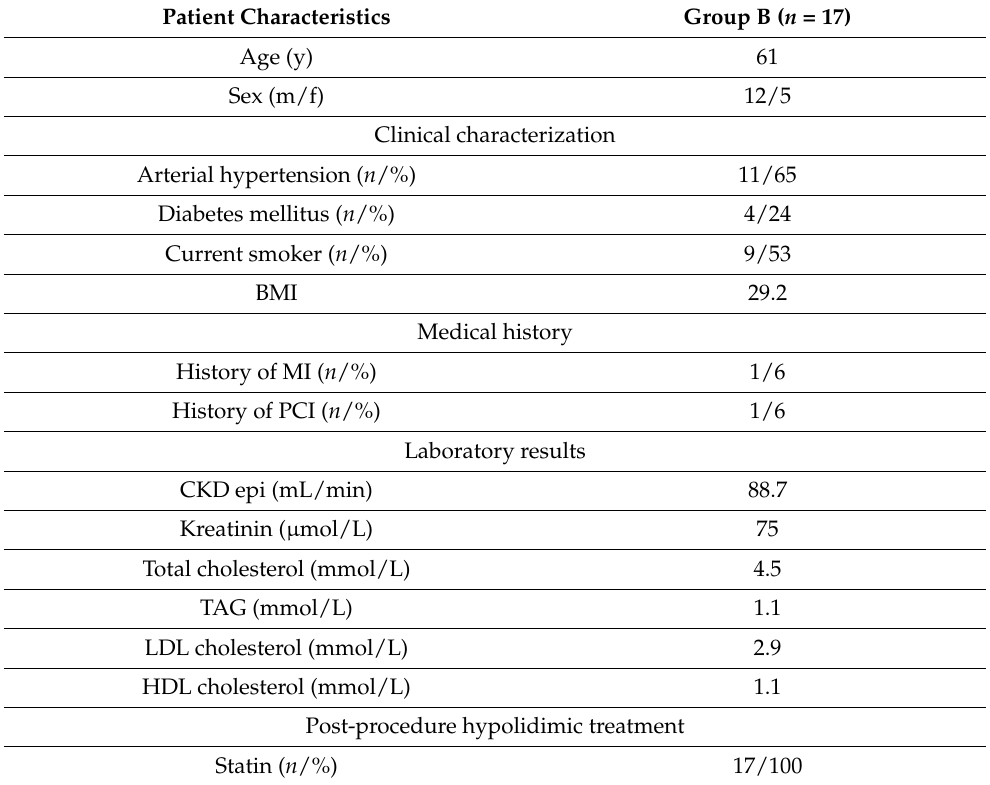
Table 2. Characteristics of the study